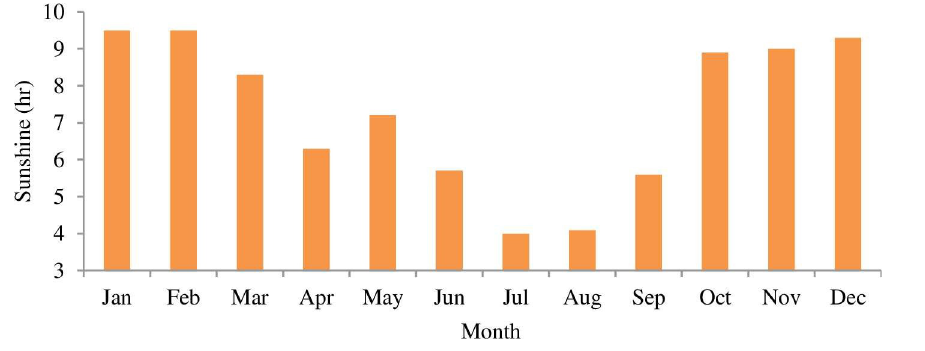
Fig 8. Hourly average bright sunshine